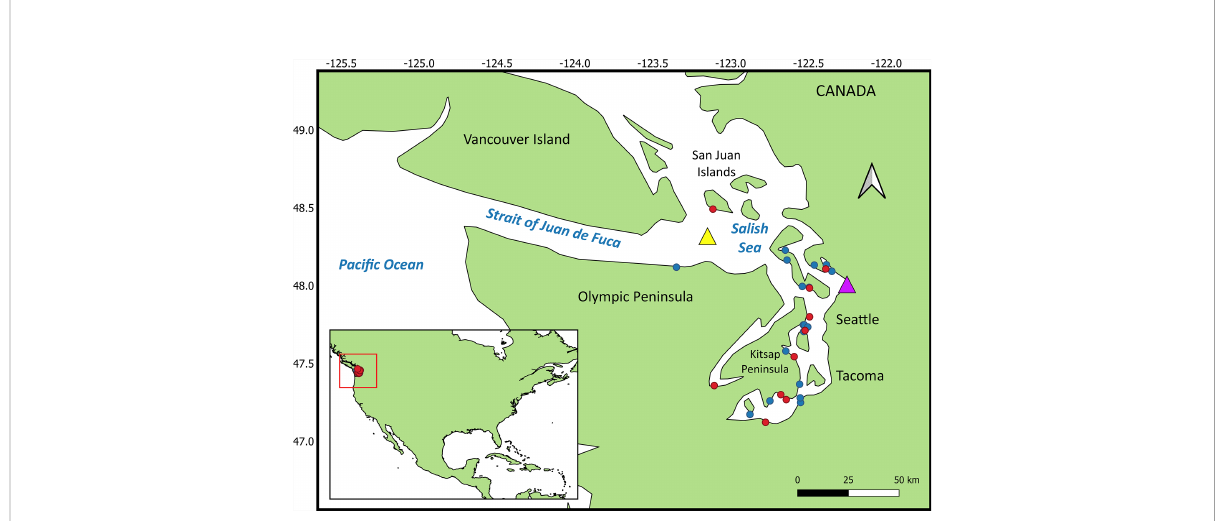
FIGURE 1 Mucormycosis cases (red dots) and controls (blue dots) in harbor porpoise. The yellow triangle is the location of the buoy that recorded mean yearly sea surface temperature. The purple triangle is the location where mean yearly precipitation was